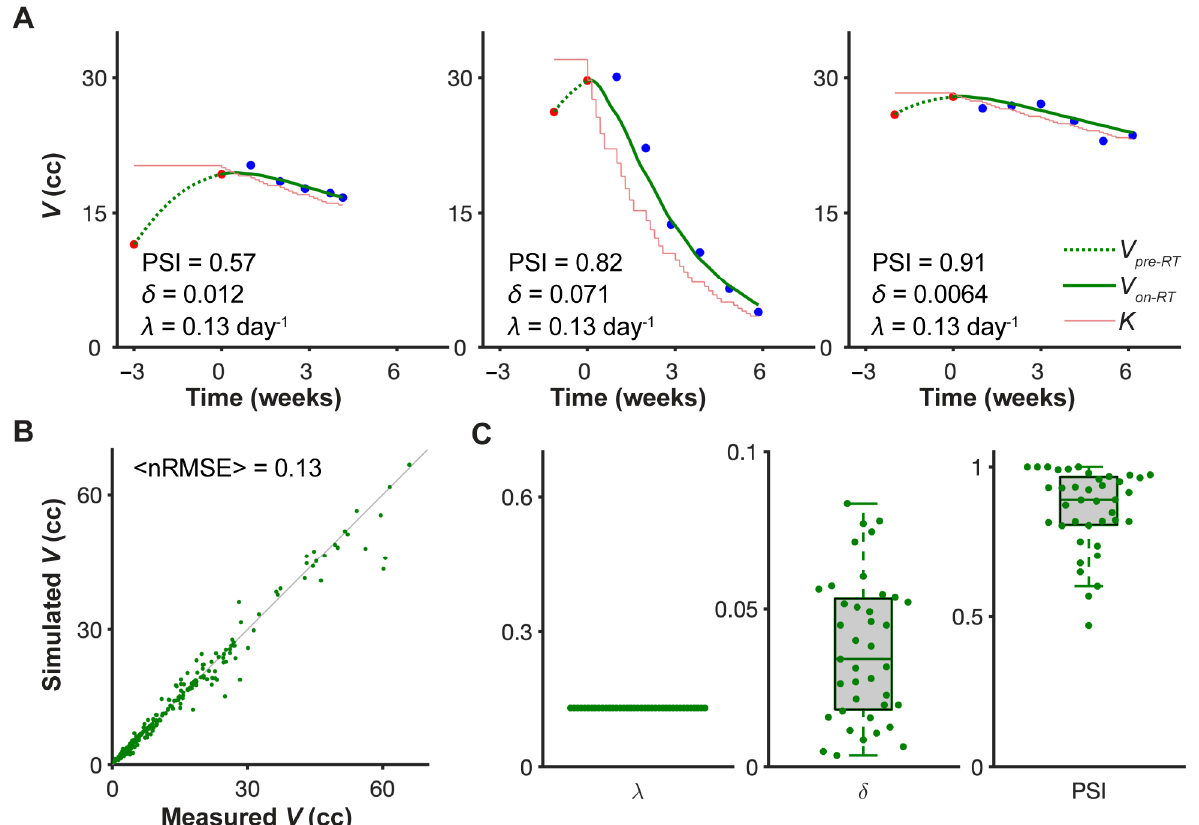
Figure 4. Model fit to longitudinal tumor volume data. ( A ) Representative model fits for three patients arranged in order of increasing PSI values. Red dots are measured pre-treatment tumor volumes; black dots on-treatment tumor volumes; the dashed green curves are the calculated pre-treatment tumor growth trajectory; the solid green curves are the fitted on-treatment tumor volume trajectories; and the thin red line indicates the calculated value of the tumor carrying capacity both before and during treatment. ( B ) Correlation of measured tumor volumes and fitted tumor volumes for all 39 patients with indicated average normalized root mean square error (<nRMSE>). Green dots indicate individual weekly tumor volumes. ( C ) Parameter distributions for all 39 patients. Volumetric tumor growth rate, λ = 0.13 day −1 , was fixed for all patients.